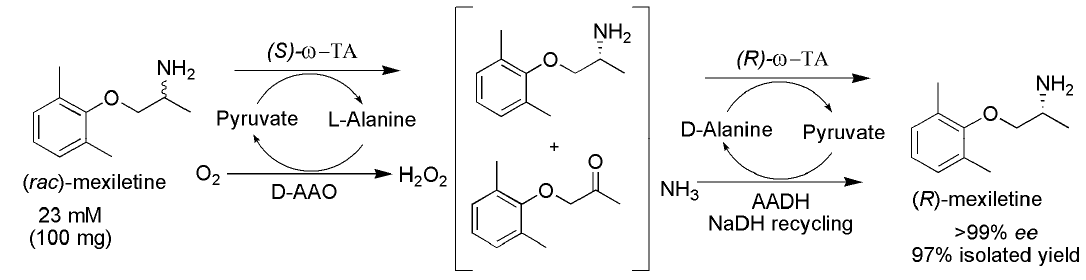
Figure 4. Use of a deracemization strategy for the synthesis of enantiopure Mexiletine (reprinted with permission from [61], Copyright (2009) American Chemical Society). (Reaction conditions: 50 mM racemic substrate, 50 mM sodium pyruvate, 20 mg whole cells of E . coli expressing ω -TAs, phosphate buffer (100 mM, pH 7.0), 1 mM PLP, 30 °C, 24 h).